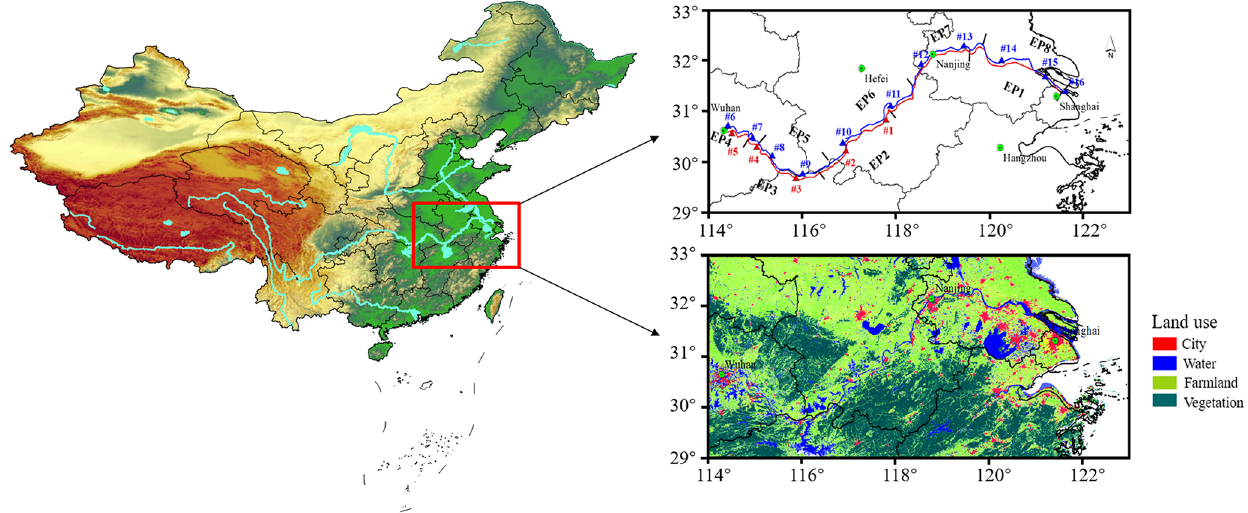
Figure 1. Cruise tracks, source region limits, the sampling sites, and land use during the